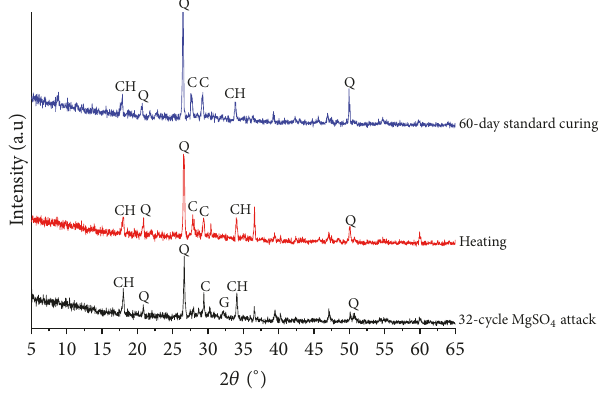
Figure 9: FTIR of OPCC in the standard curing condition of 60 days, heating condition, and 32-cycle MgSO 4 attack environment,